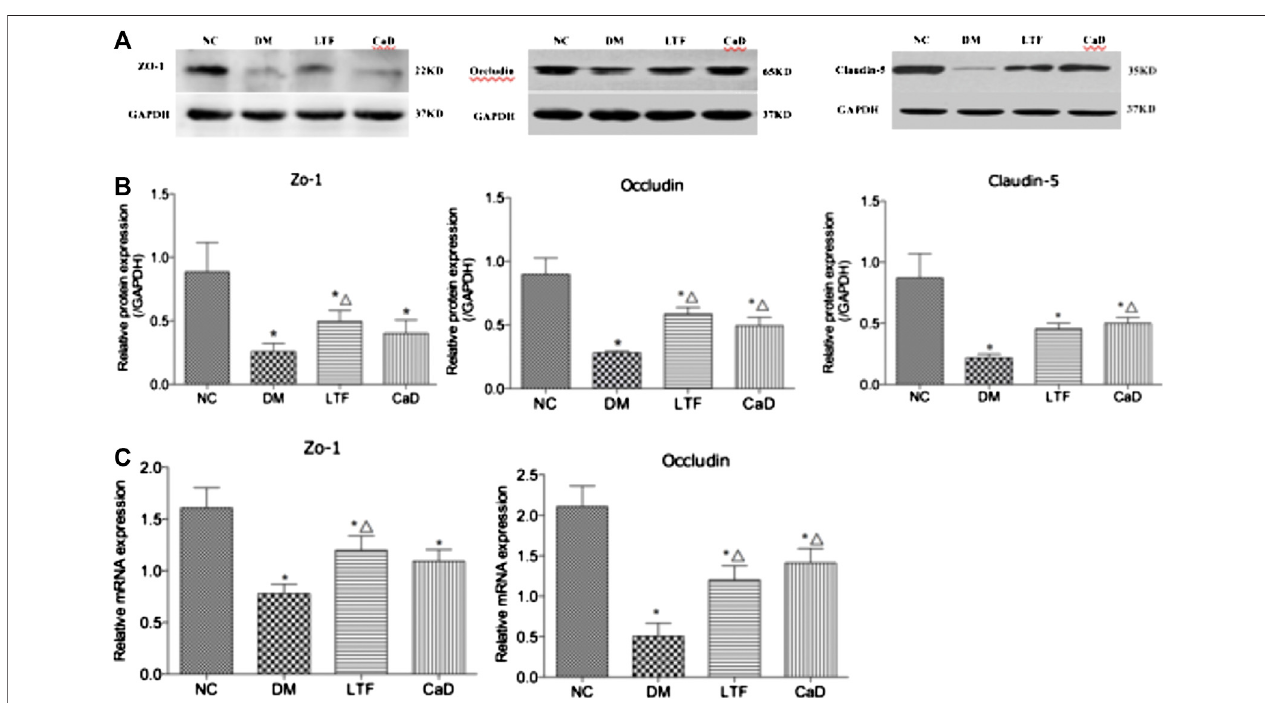
FIGURE 5 | Effect of LTF and CaD on the ZO-1, Occludin and Claudin-5 expressions. (A, B) Western blot and quantitative measurement of retinal ZO-1, Occludin and Claudin-5; C Real-time PCR analysis of ZO-1 and Occludin. Data are mean ± SD from six rats per group, and the experiments were repeated independently four times (* p < 0.05: vs. NC group; △ p < 0.05: vs. DM group).